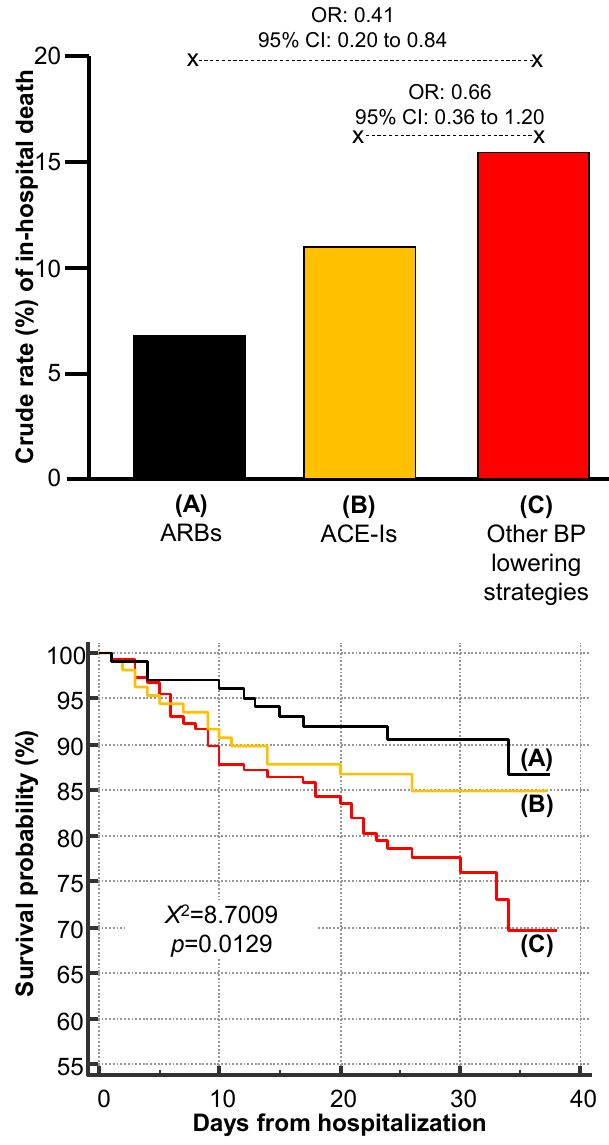
Figure 1. Risk of in-hospital death among hypertensive patients hospitalized for COVID-19 according to subgroups of antihypertensive therapy (upper panel). Survival curves (lower panel) were estimated using Kaplan–Meier product limit method and compared with the Mantel (log-rank) test. Legend: ACE-Is = ACE inhibitors; ARBs = angiotensin receptor blockers; BP = blood pressure; CI = confidence interval; OR = odds ratio.